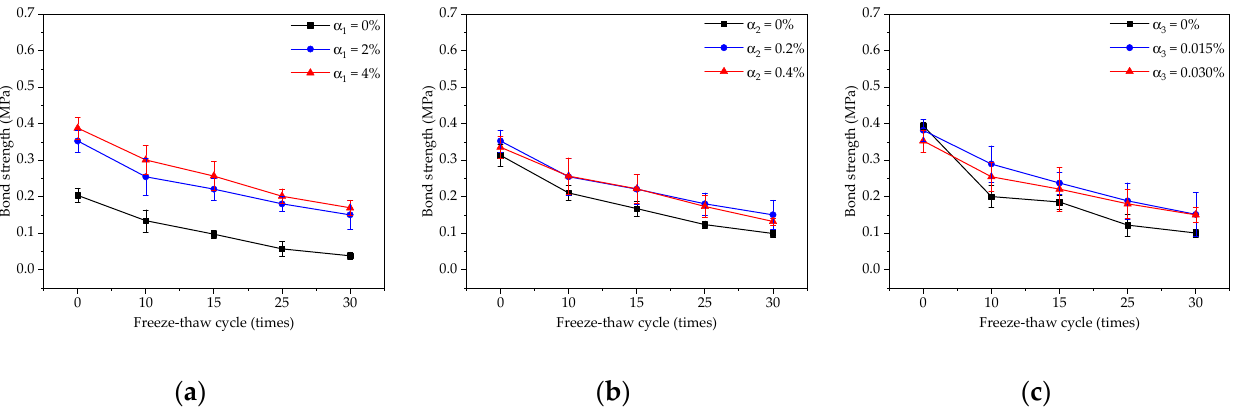
Figure 1. Influence of three factors on bond strength: ( a ) the factor of redispersible emulsion powder; ( b ) the factor of polypropylene fiber; ( c ) the factor of air-entraining agent.